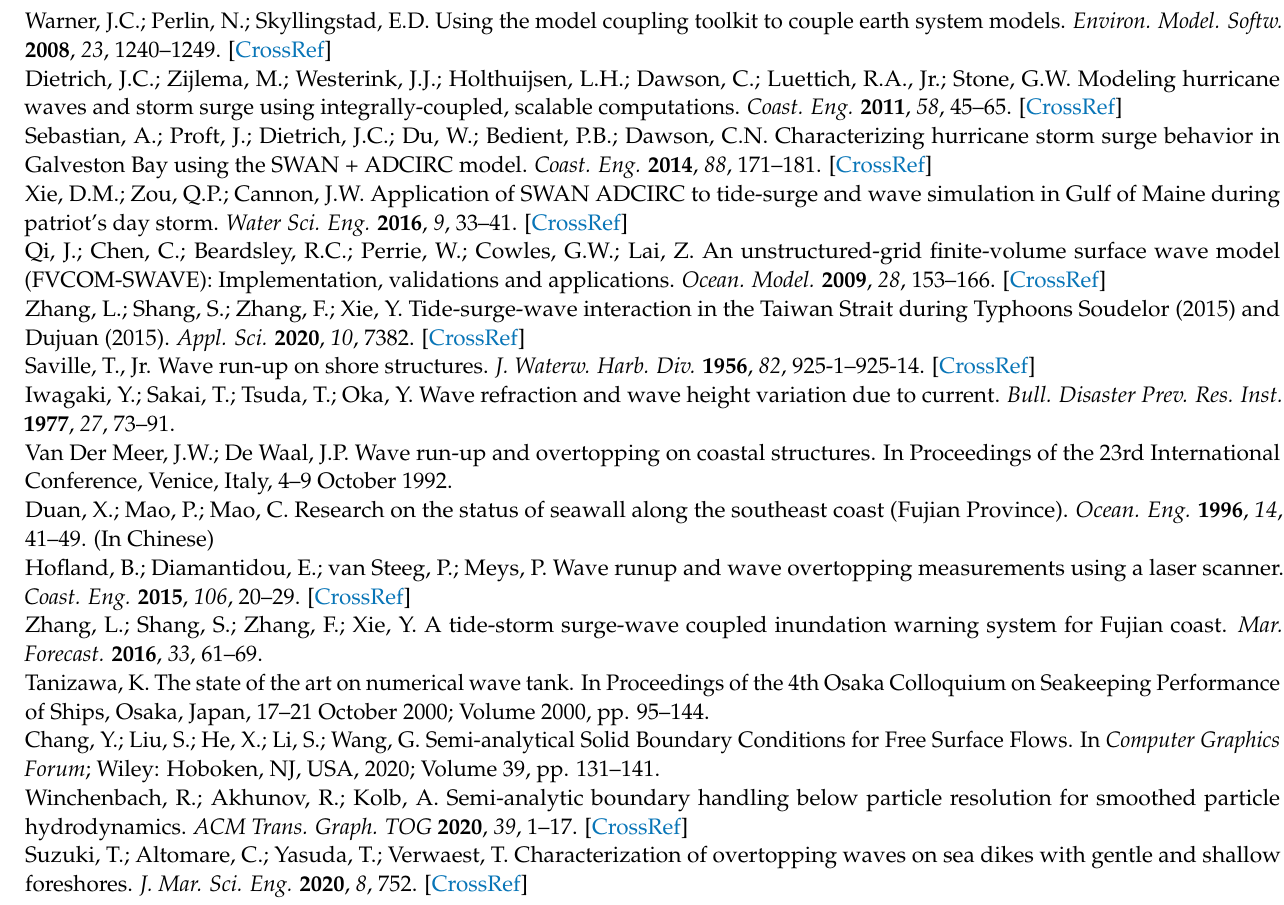
(3) The typhoon process usually lasts 3–5 days. Based on an analysis of tide level and wave simulations three days before the landfall of the typhoons, eight sets of exper- iments were conducted. The results show that the risk of over-topping increases during high tide. The wave run-up height decreases as the water becomes deeper under the same wave conditions as a result of the ocean wave being stretched and shortened by the different propagation speeds at crest and